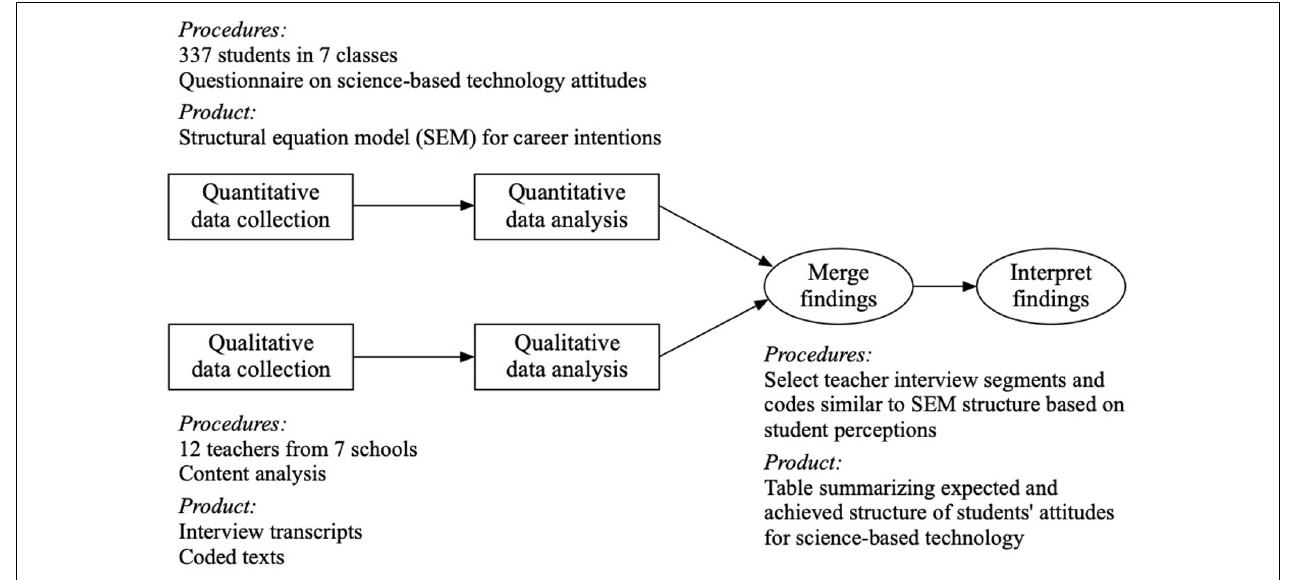
FIGURE 2 | Flow diagram of the mixed-methods research